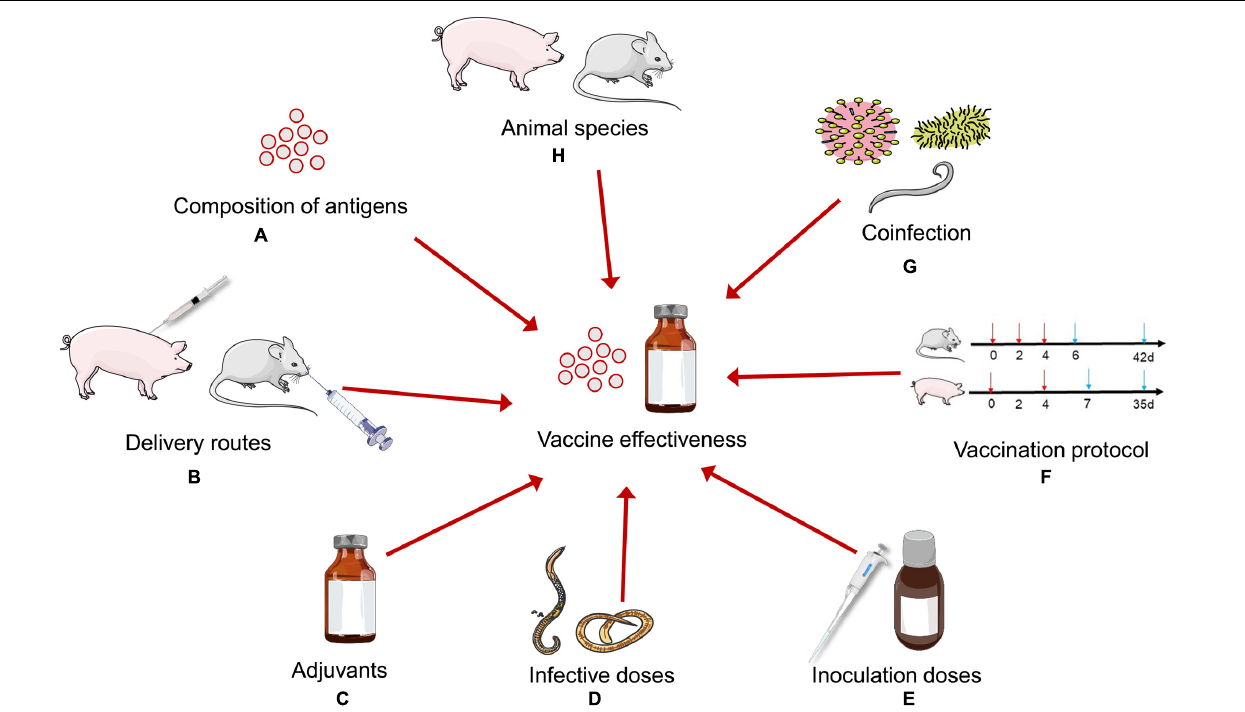
FIGURE 2 | Factors influencing the effectiveness of Trichinella spiralis vaccines in animal models. (A) Various candidate antigens show different protective effects. (B) Several vaccine delivery routes have been used to improve the effectiveness of T. spiralis vaccines. (C) Suitable adjuvants play a very important role in vaccines effectiveness. (D) Infective doses of T. spiralis may determine the effectiveness of T. spiralis vaccines in animal models. (E) The efficiency of immunization also depends on inoculation doses of vaccines. (F) There is a lack of a standardized vaccination protocol in animal models. (G) Coinfection change the host’s immune response to affect the effectiveness of T. spiralis vaccines. (H) The same antigen may exhibit different protective effects in different animal